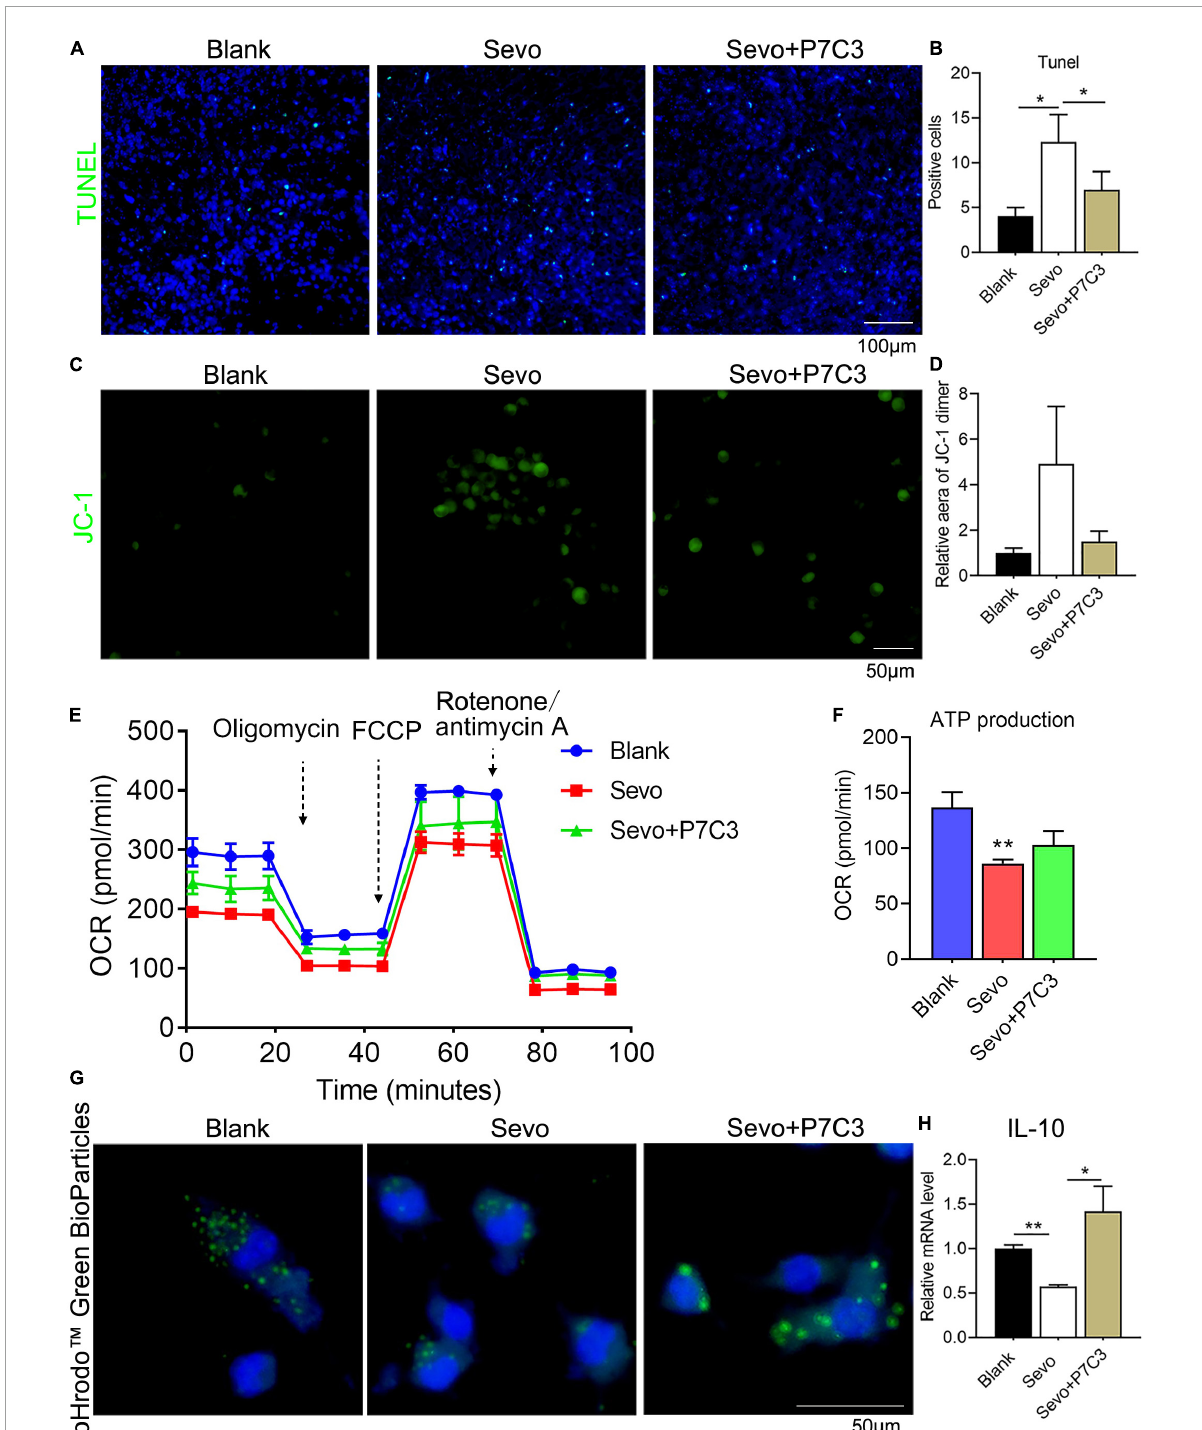
FIGURE5 NAD supply ameliorates mitochondrial dysfunction and cell phagocytosis induced by sevoflurane exposure. (A,B) Tunel assay of BV2 cell line after P7C3 treatment and the quantification of Tunel-positive cells. p(Blank vs. Sevo) = 0.011, p(Sevo vs. Sevo+P7C3) = 0.027. N = 3. (C,D) JC-1 staining of BV2 cell line after P7C3 treatment and the quantification of positive-staining area. p(Blank vs. Sevo) = 0.15, p(Sevo vs. Sevo+P7C3) = 0.2. N = 3. (E,F) The overall mitochondrial metabolism using Seahorse experiment of BV-2 cell line after P7C3 treatment, and ATP production detected by Seahorse experiment. p(Blank vs. Sevo) = 0.0032, p(Sevo vs. Sevo+P7C3) = 0.088. N = 3. (G) pHrodo TM Green BioParticles staining of BV-2 cell line to determine the phagocytic function after P7C3 treatment. (H) qRT-PCR of BV-2 cell line shows the mRNA level of anti-inflammatory factor IL-10. p(Blank vs. Sevo) = 0.005, p(Sevo vs. Sevo+P7C3) = 0.022. N = 3. Scale bar, 50 µ m. * P ≤ 0.05, ** P ≤